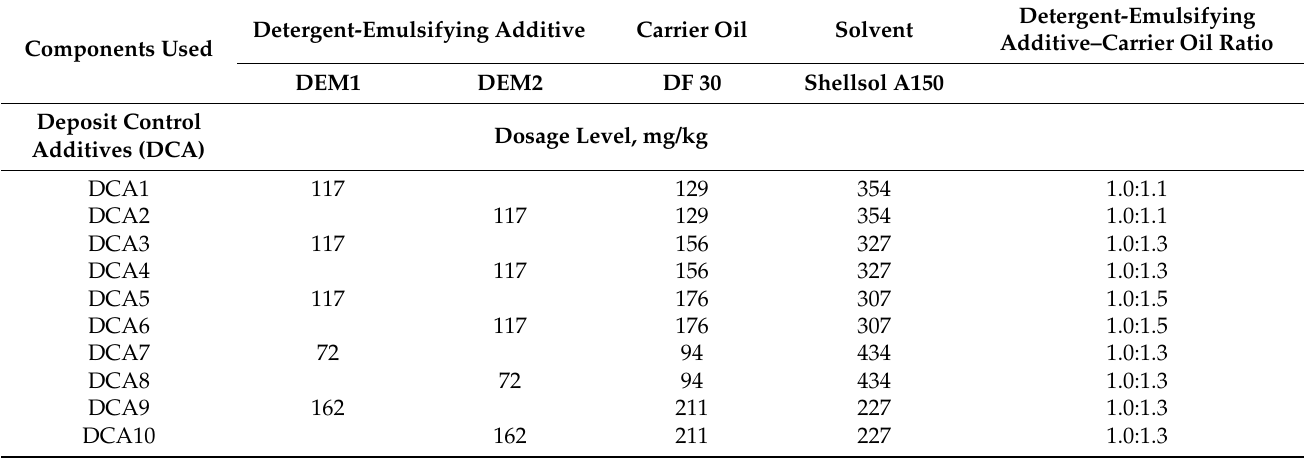
Table 2. Compositions of the developed additive batch formulations.